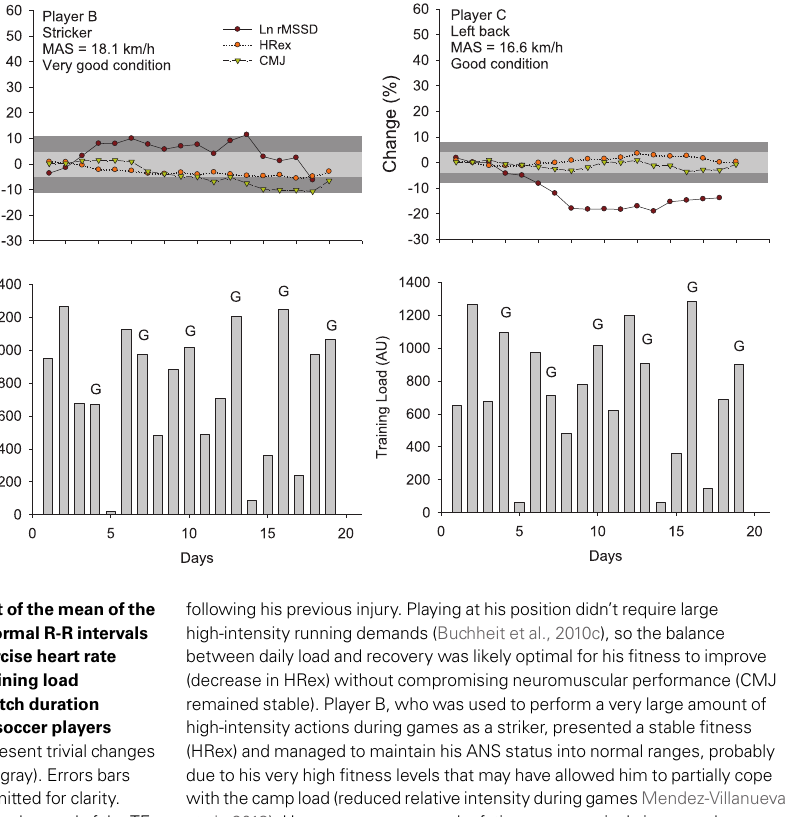
following his previous injury. Playing at his position didn’t require large high-intensity running demands (Buchheit et al., 2010c), so the balance between daily load and recovery was likely optimal for his fitness to improve (decrease in HRex) without compromising neuromuscular performance (CMJ remained stable). Player B, who was used to perform a very large amount of high-intensity actions during games as a striker, presented a stable fitness (HRex) and managed to maintain his ANS status into normal ranges, probably due to his very high fitness levels that may have allowed him to partially cope withthecampload(reducedrelativeintensityduringgamesMendez-Villanueva et al., 2013). However, neuromuscular fatigue progressively increased (decreased CMJ), consistent with the large playing demands. Finally, player C showed stable fitness and CMJ performance, but a clear decrease in HRV. He played the entire duration of games and in relation to his average fitness level, might not have completely coped with the load by the end of the camp. Nevertheless, thefactthathisCMJperformance remainedstableisconsistent with the moderate neuromuscular demands of playing wide defender within